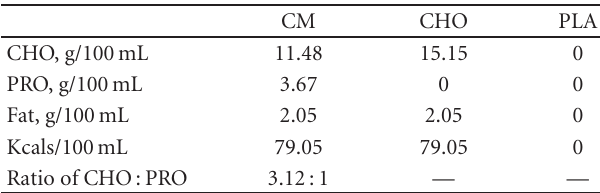
Table 3: Energy and macronutrient content of the